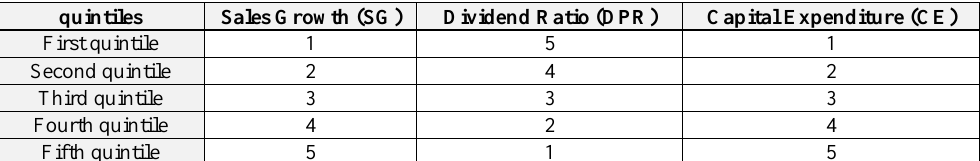
Table 2. Determining the scores of variables according to Park and Chen (2006) method